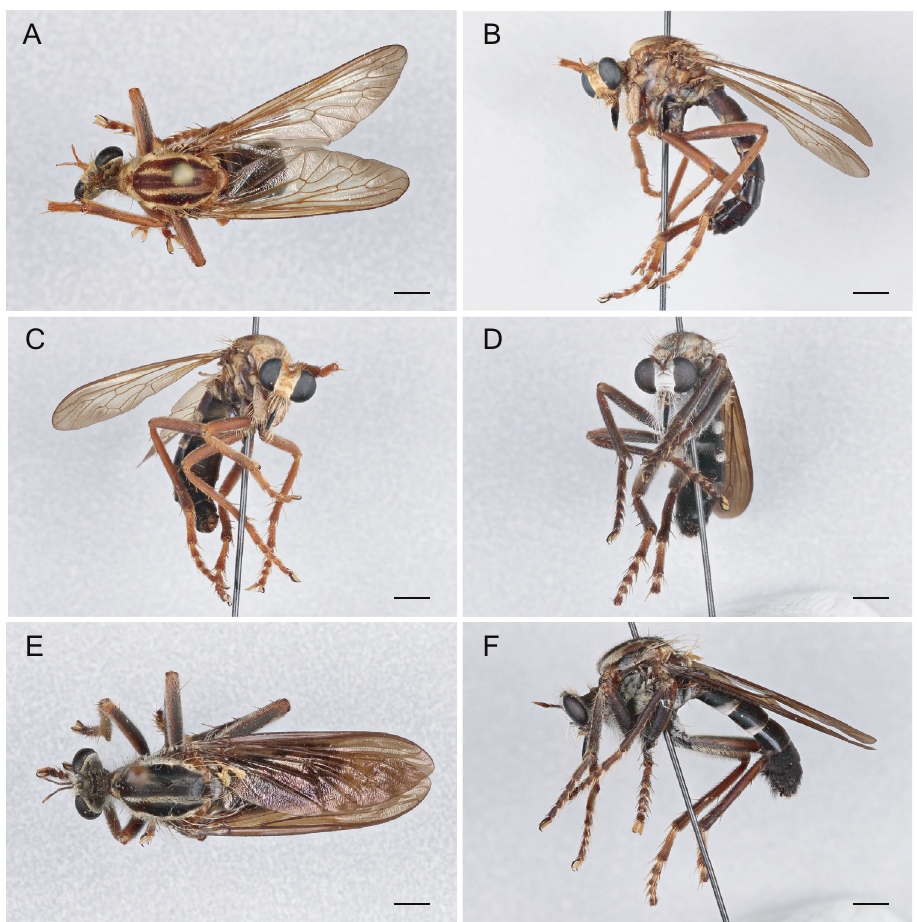
Figure 12. Saropogon dispar Coquillett, 1902 Female (UCBMEP0280509): A dorsal view B lateral view C anterior view; Male (UCBMEP0280508): D anterior view E dorsal view F lateral view. Scale bars: 2